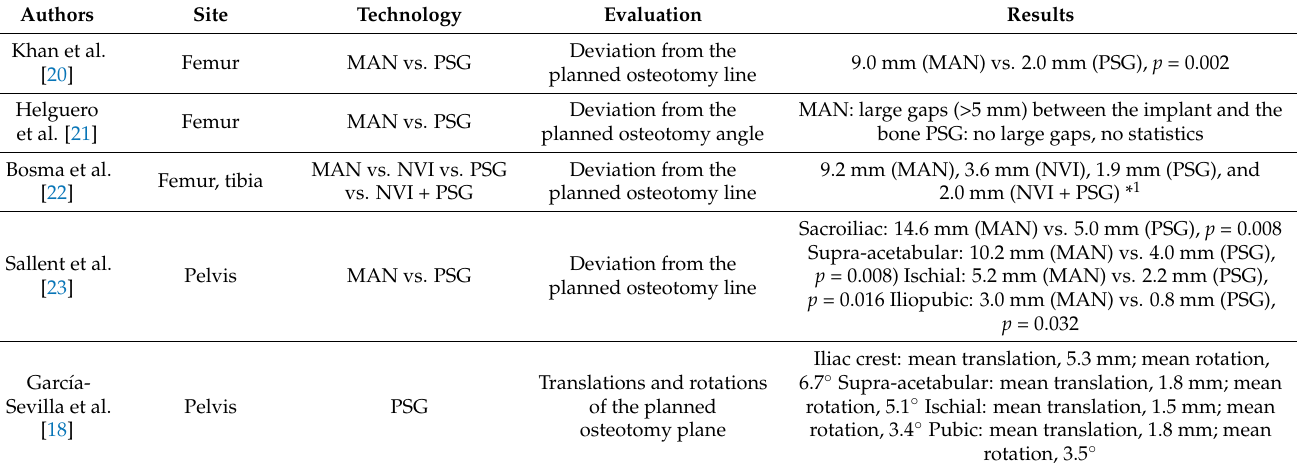
Table 1. Cadaver study reports of bone resection/manual resection versus navigation resection vs. PSG